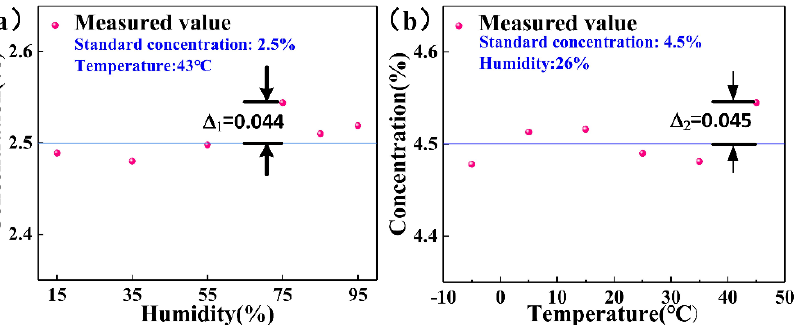
Figure 7. After concentration compensation, the actual measured value of standard concentration gas in different ( a ) humidity environments and ( b ) temperature.